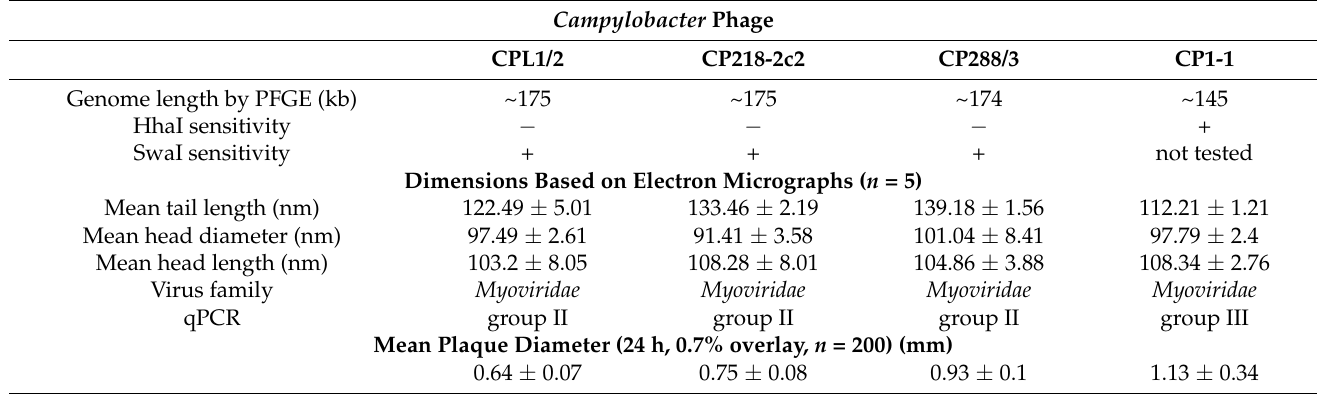
Figure 2. Plaque morphology of the four examined myovirus phages ( a – d ) and micrographs showing the morphology of the virions ( e – h ). All four phages, CPL1/2 ( a , e ), CP218-2c2 ( b , f ), CP288/3 ( c , g ), and CP1-1 ( d , h ), formed clear plaques on C. coli strain NCTC 12667 ( a – c ) and C. jejuni strain NCTC 12662, respectively ( d ); scale bar represents 2 mm. The virions consisted of an icosahedral head and a contractile tail structure with tail fibers; negatively stained phage particles with 2% uranylacetate; scale bar represents 100 nm. Table 3. Morphologic and genomic characteristics of the examined bacteriophages. Genome size and HhaI and SwaI restriction sensitivity were determined based on PFGE analysis, virion dimensions based on electron micrographs, and mean plaque diameters based on macrographs ( ±